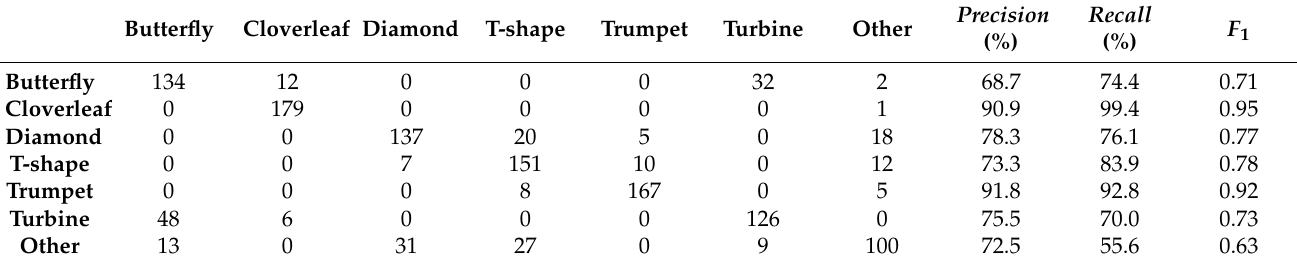
Table 4. Confusion matrix and evaluation metrics of the classification results of complex junctions using the AlexNet-based SE model.